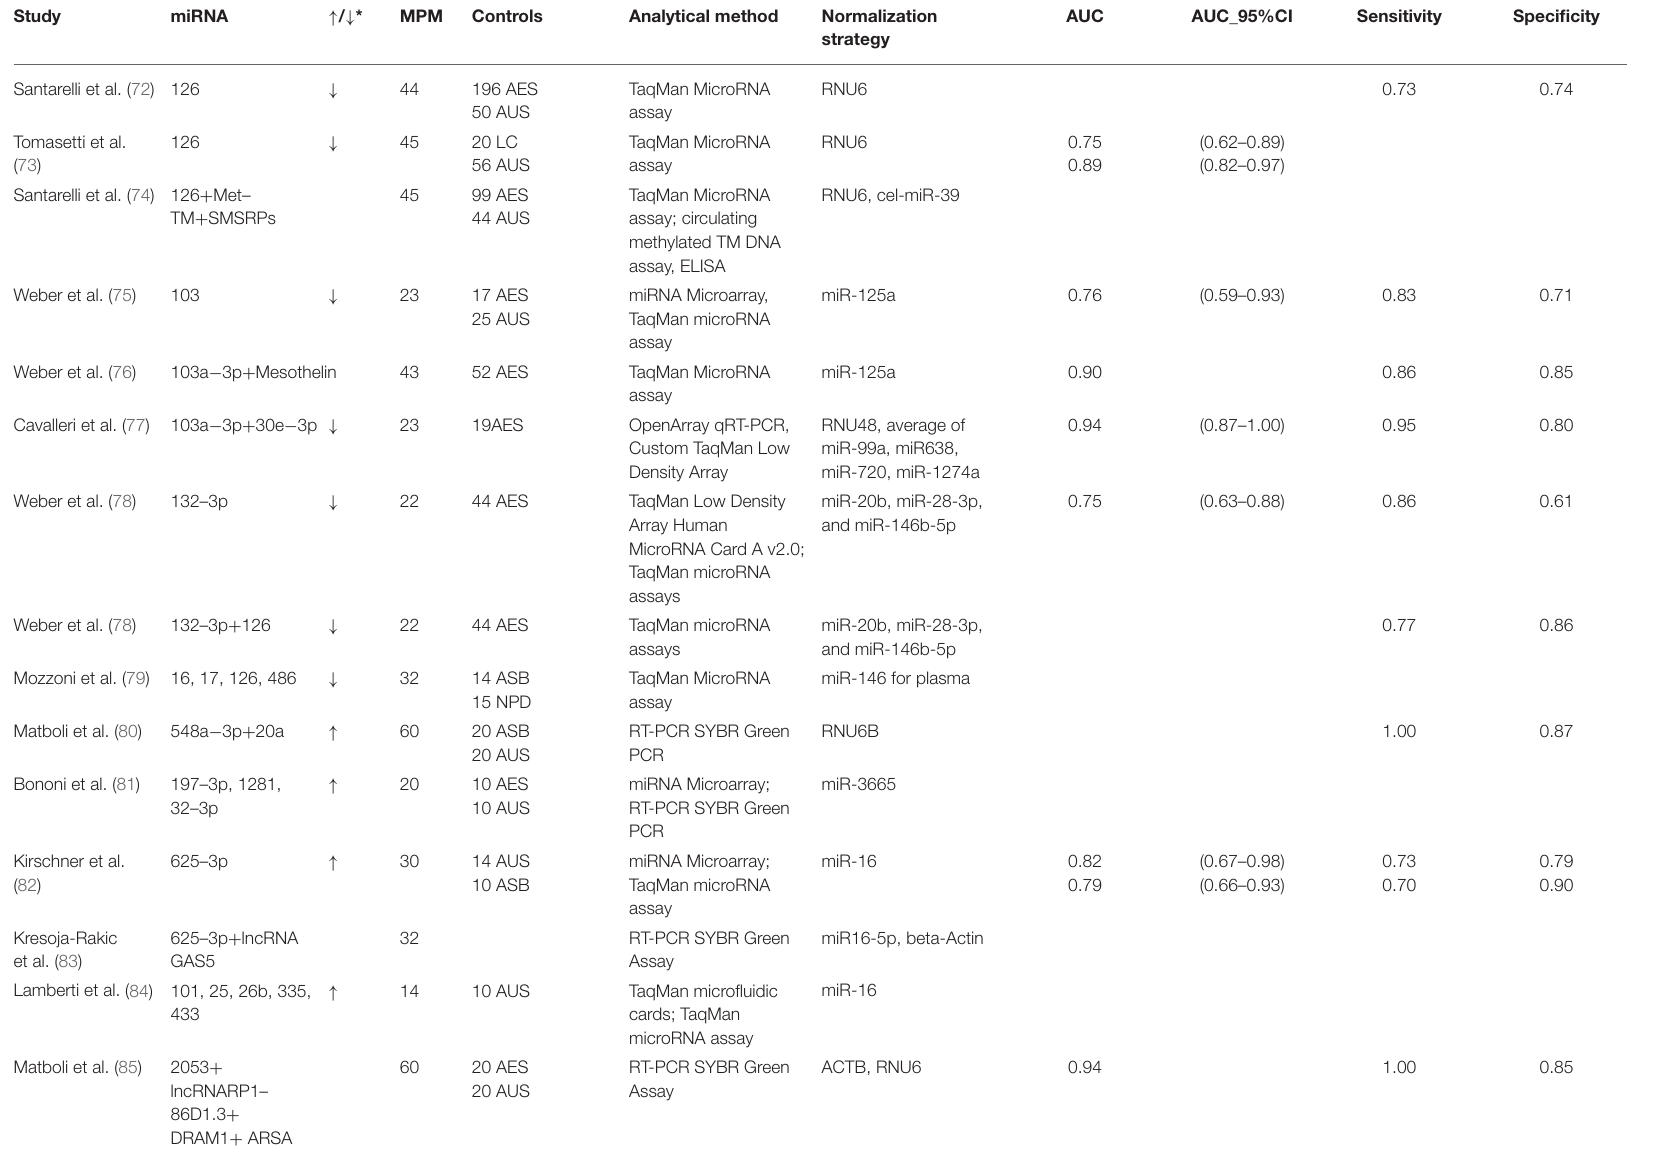
TABLE 1 | Studies evaluating miRNA expression levels in serum or